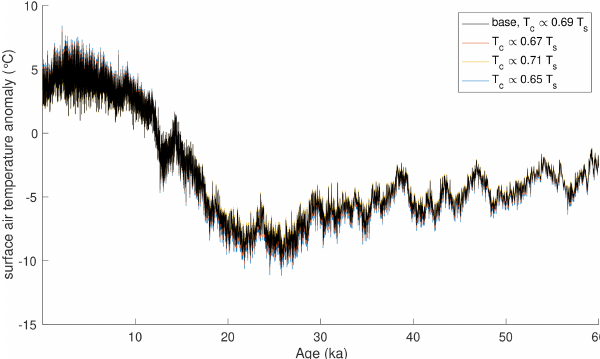
Figure A27. Sensitivity of the T s reconstruction for WDC to the re- lationship between T c and T s . Our base scenario is shown in black ◦ C ± 0 . 02 ◦ C ( T c ∝ 0 . 69 ◦ C T s ), while the spread associated with a ◦ C un- certainty in the scaling factor is shown in red and gold. For compar- ◦ C ison the results from a weaker slope of 0 . 65 ◦ C are shown in blue. This range of scaling factors has little impact on the reconstructed temperature history and may be difficult to